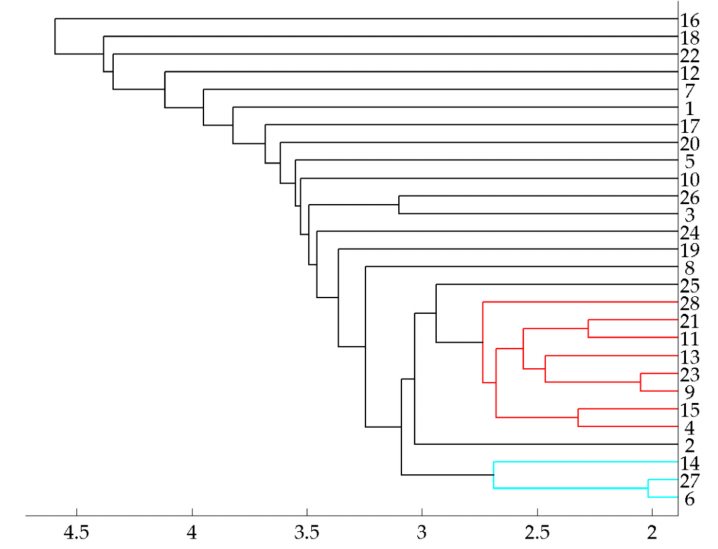
Figure 5. Dendogram of hierarchical clustering of participants; the x -axis represents the relative distance of individual participants, with the color cut-o ff being 60% of the biggest